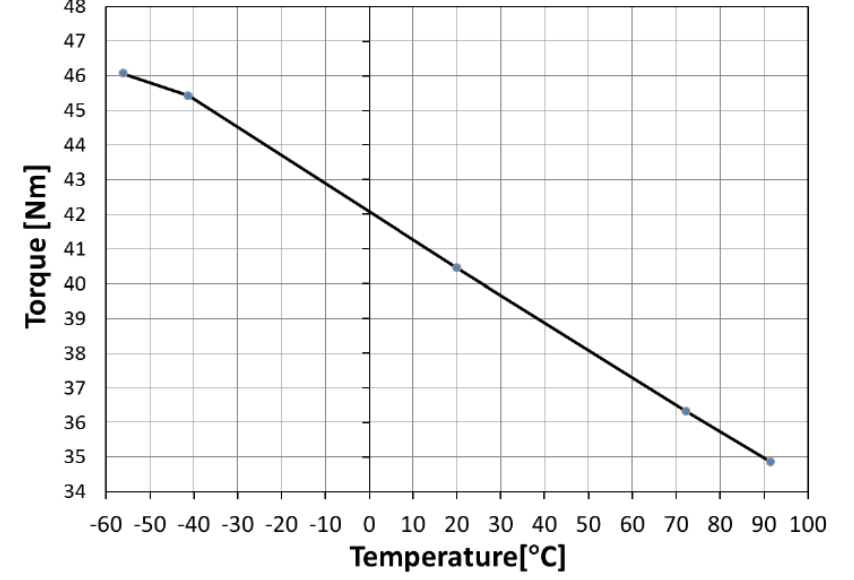
Figure 5. Maximum torque vs.